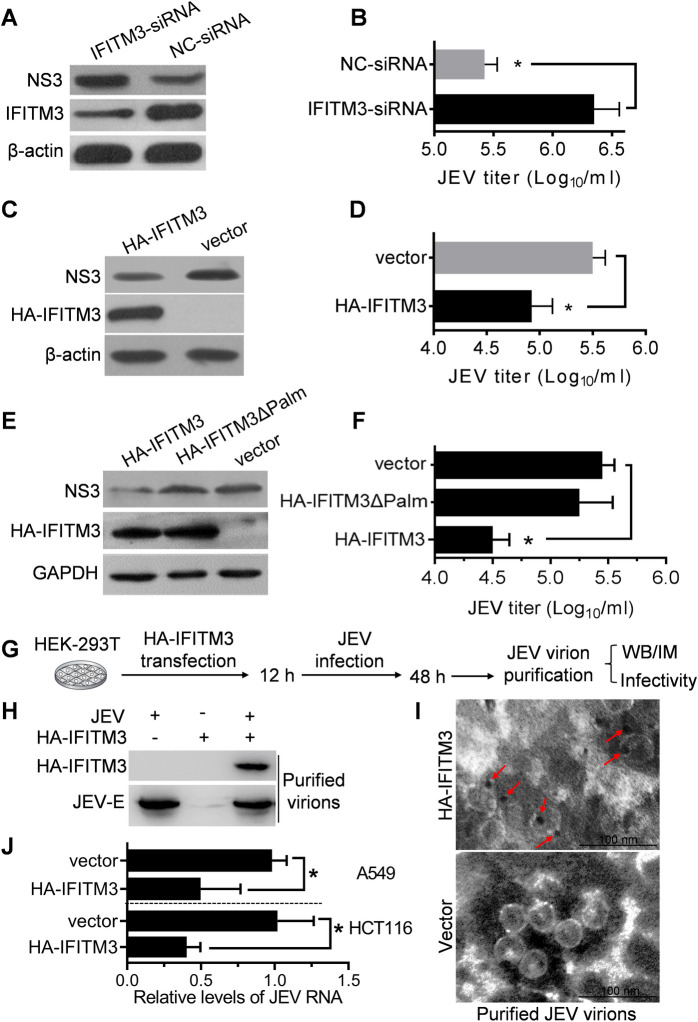
Inhibitory effect of IFITM3 on JEV replication.(A and B) A549 cells were transfected with IFITM3 siRNA for 72 h and then infected with JEV at 1 MOI for 24 h, IFITM3 and viral NS3 proteins expression were detected by western blot (A) and JEV titres in the supernatants were measured by TCID50 assay (B). (C and D) A549 cells were transfected with plasmids expressing HA-IFITM3 or empty vector for 36 h, followed by infection with JEV at 1 MOI for 24 h, IFITM3 and viral NS3 proteins were detected by western blot (C) and JEV titres in the supernatants of HA-IFITM3 and control vector cells were measured by TCID50 assay (D). (E and F) A549 cells were transfected with HA-IFITM3 or HA-IFITM3ΔPalm expressing plasmid for 36 h, followed by infection with JEV at 1 MOI for 24 h. viral NS3 proteins expression (E) and JEV titres (F) were measured as above. (G) Schematic representation of experiments. WB, western blot. IM, immunoelectron microscopy. (H and I) Detection of HA-IFITM3 incorporation into JEV particles. JEV particles were purified from cells expressing HA-IFITM3 or control cells by sucrose density gradient ultracentrifugation. The incorporation of HA-IFITM3 into virion was analysed by western blot (H) and immunoelectron microscopy (I) (red arrows indicate HA-IFITM3 labelled with gold particles near virion surface). (J) A549 and HCT116 cells were infected with the purified JEV virions at 1 MOI and incubated for 12 h. JEV replication at viral RNA levels was measured by qRT-PCR. HA-IFITM3, JEV virions purified from cells expressing HA-IFITM3. Vector, JEV virions purified from control cells. Unpaired t test, *P<0.05.